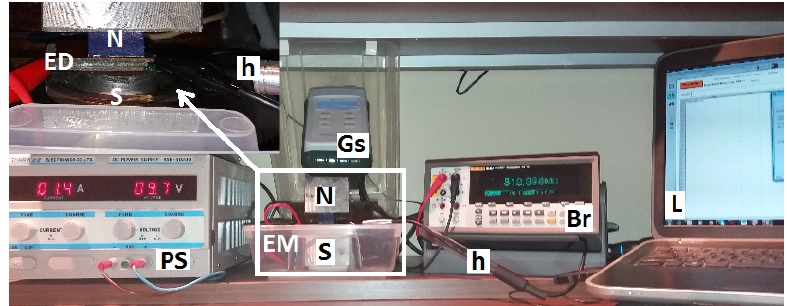
Figure 3. Experimental setup for studying magnetoelectric and magnetodielectric effects (MDEs)